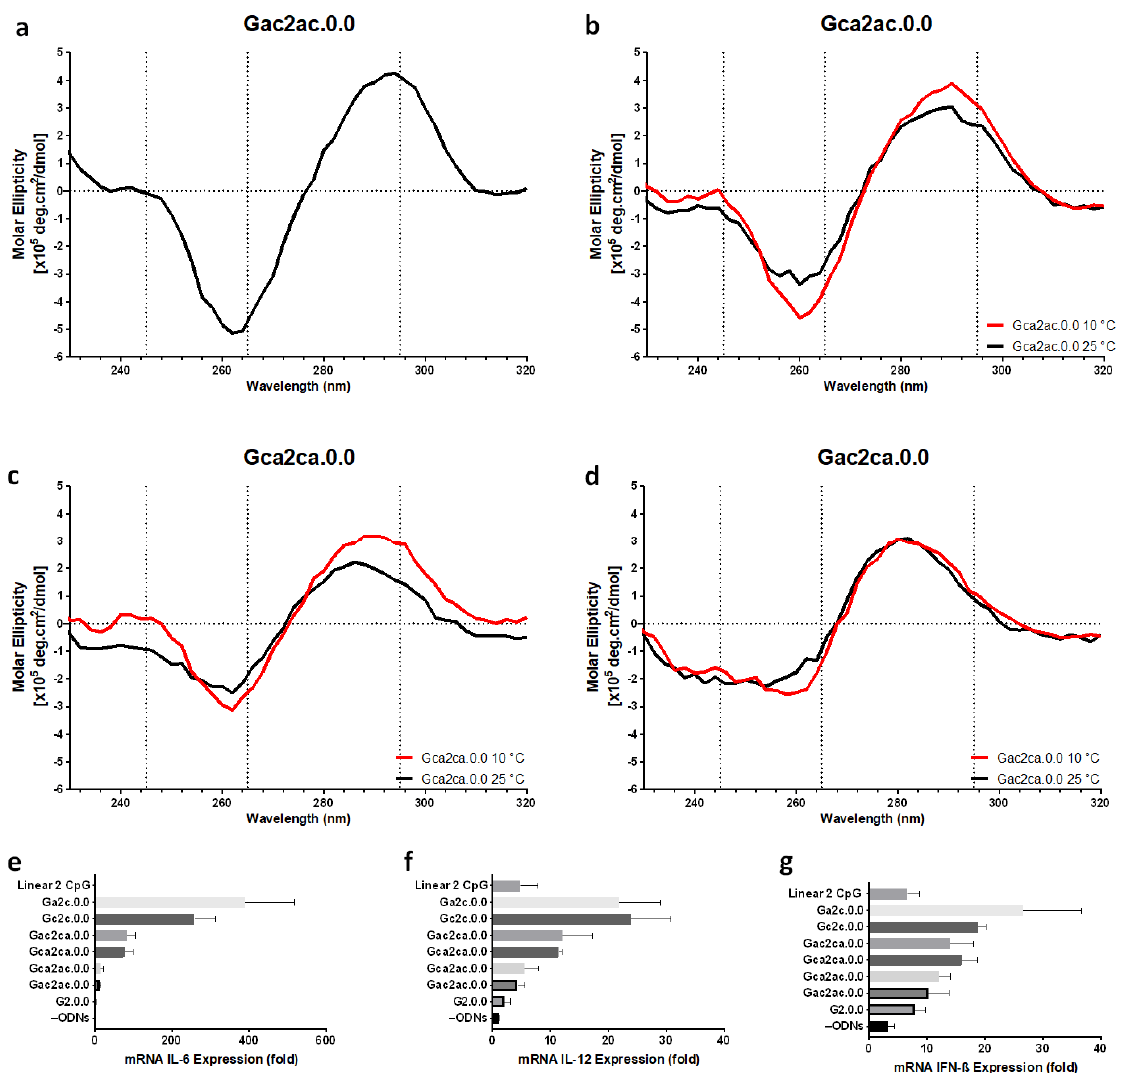
Figure 5. Effect of flanking sequence between the CpG motif and G-tetrad in the first loop on antiparallel G-quadruplex formation and cytokine induction. Circular dichroism spectra of ( a ) Gac2ac.0.0, ( b ) Gca2ac.0.0, ( c ) Gca2ca.0.0, and ( d ) Gac2ca.0.0 at 25 ◦ C (black line) or 10 ◦ C (red line) were observed. Relative expression level of ( e ) IL-6, ( f ) IL-12, and ( g ) IFN-ß mRNA transcription in RAW264 cells stimulated by Linear 2CpG, G2.0.0, Ga2a.0.0, Gc2c.0.0, Gac2ac.0.0, Gac2ca.0.0, Gca2ac.0.0, and Gca2ca.0.0. –ODNs indicate RAW264 cells with only D-PBS buffer added. Data are presented as the mean ± SD ( n =